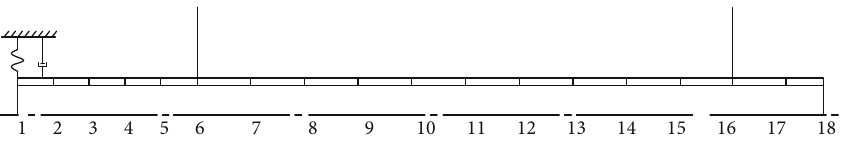
Figure 3: Finite element model of the high-pressure rotor.